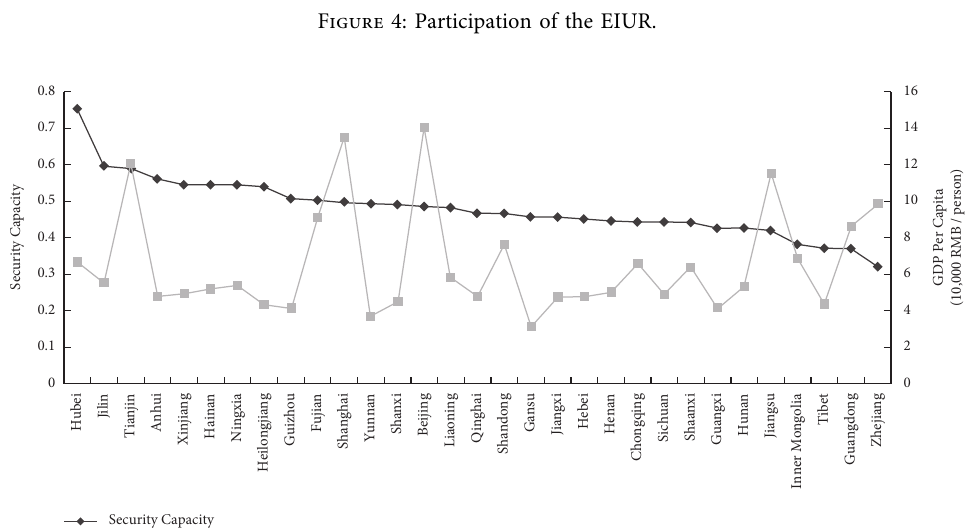
Figure 4: Participation of the EIUR.